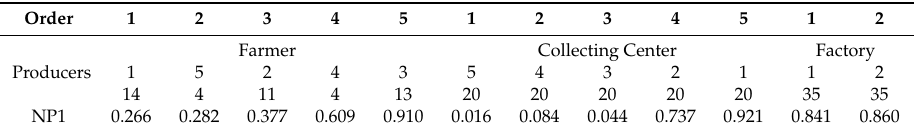
Table 2. Arranging random numbers in each vector.